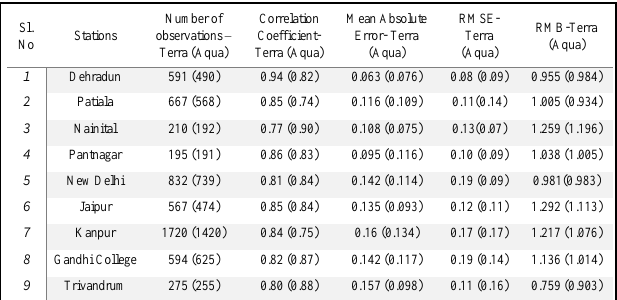
Table 1. Statistical parameters between MODIS 3-km AOD at 550nm Terra (Aqua) and ground measured AODs at selected stations across the India during